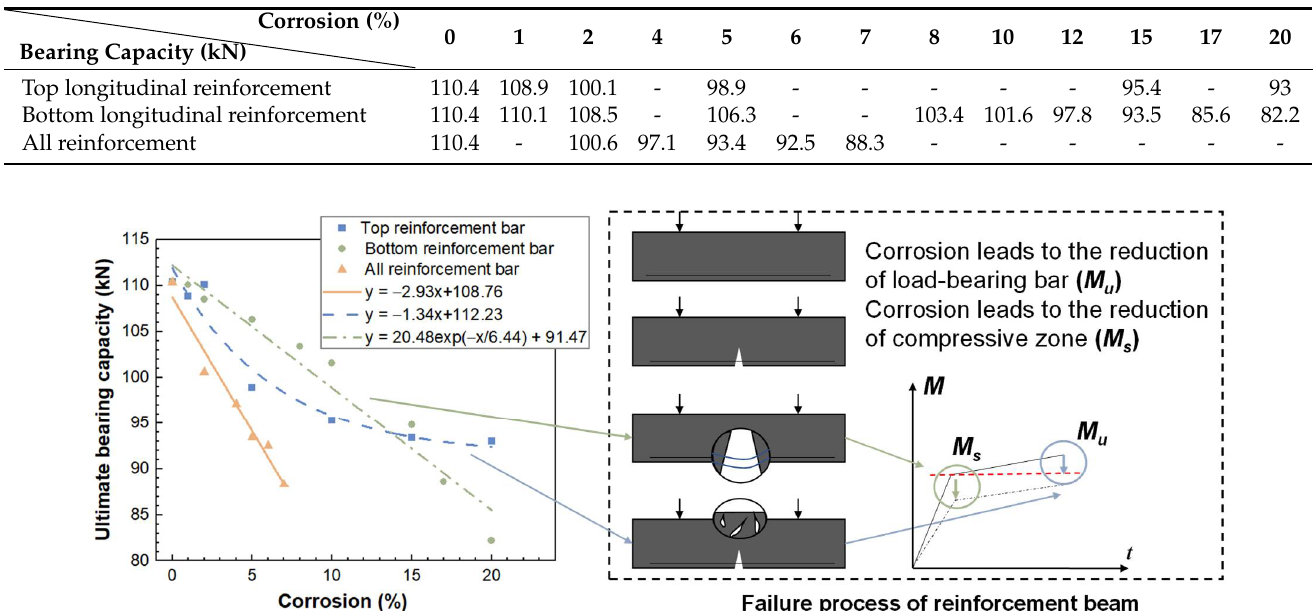
Figure 9. Influence of different rust patterns on the bearing capacity of RC